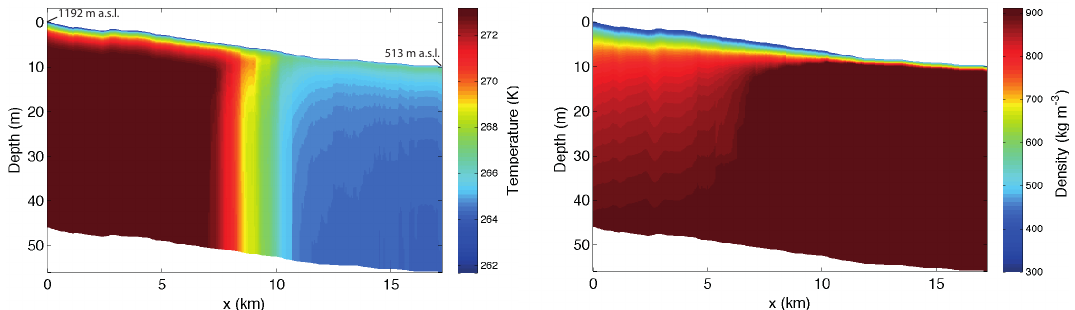
Fig. 10. Cross-sectional vertical profiles of the subsurface temperature (left panel) and density (right panel) along the main flow line marked in Fig. 1. A vertical shift of the profiles is applied to show altitudinal differences along the cross-section.